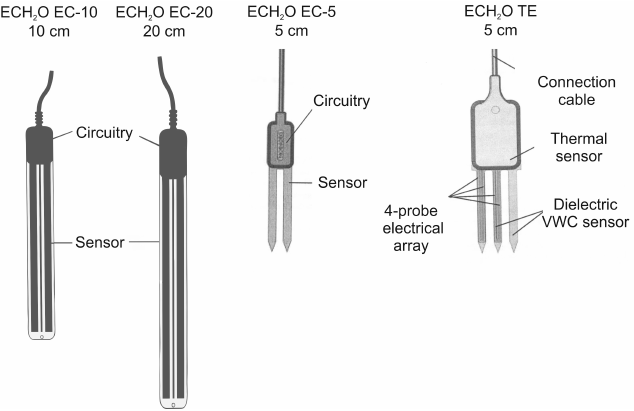
Figure 2. Scheme of tested soil water sensors from the ECH 2 O family (Decagon Devices Inc., Pullman, WA, USA). Table 1. Factory calibration equations for sensors from the ECH 2 O family using Decagon datalogger (Equations (8)–(11)).